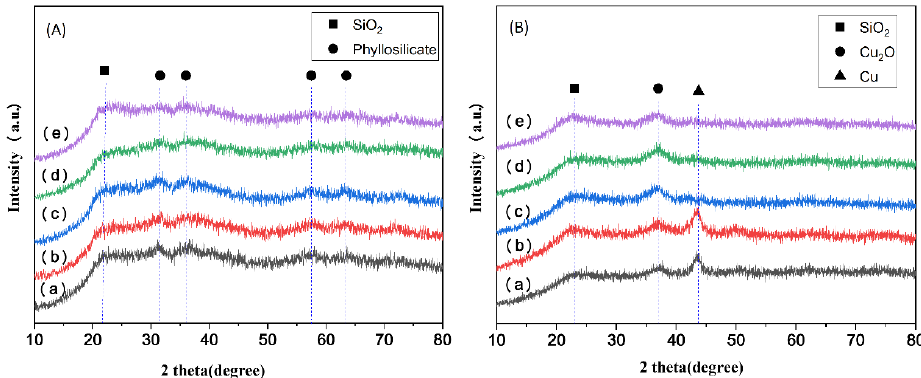
Figure 3. XRD patterns of ( A ) the calcined catalysts and ( B ) the reduced catalysts xE-Cu/SiO 2 . (a) Cu/SiO 2 , (b) 0.04E-Cu/SiO 2 , (c) 0.08E-Cu/SiO 2 , (d) 0.12E-Cu/SiO 2 , (e) 0.3E-Cu/SiO 2 .